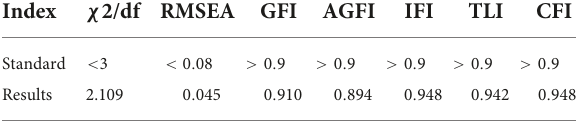
TABLE 6 Confirmatory factor model fitting